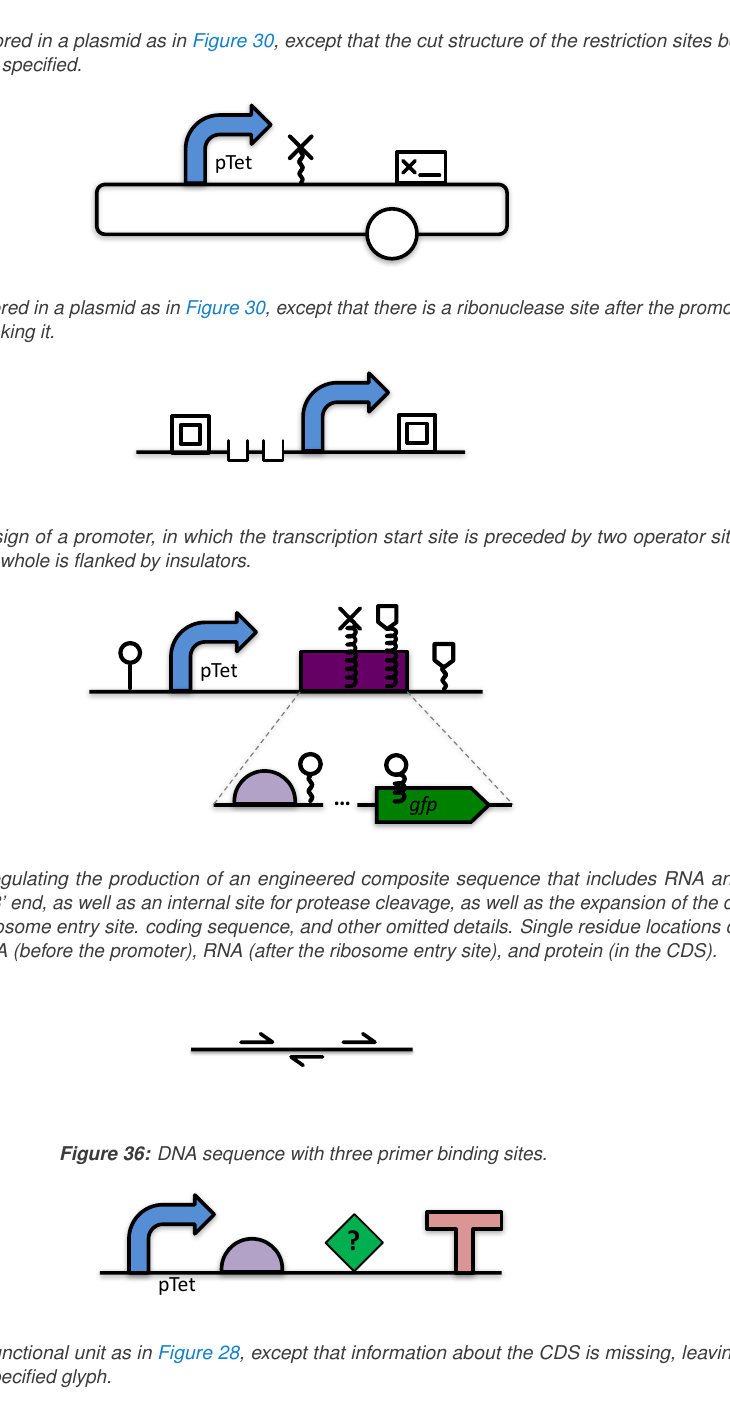
Figure 37: The same functional unit as in Figure 28, except that information about the CDS is missing, leaving it to fall back on the default unspecified